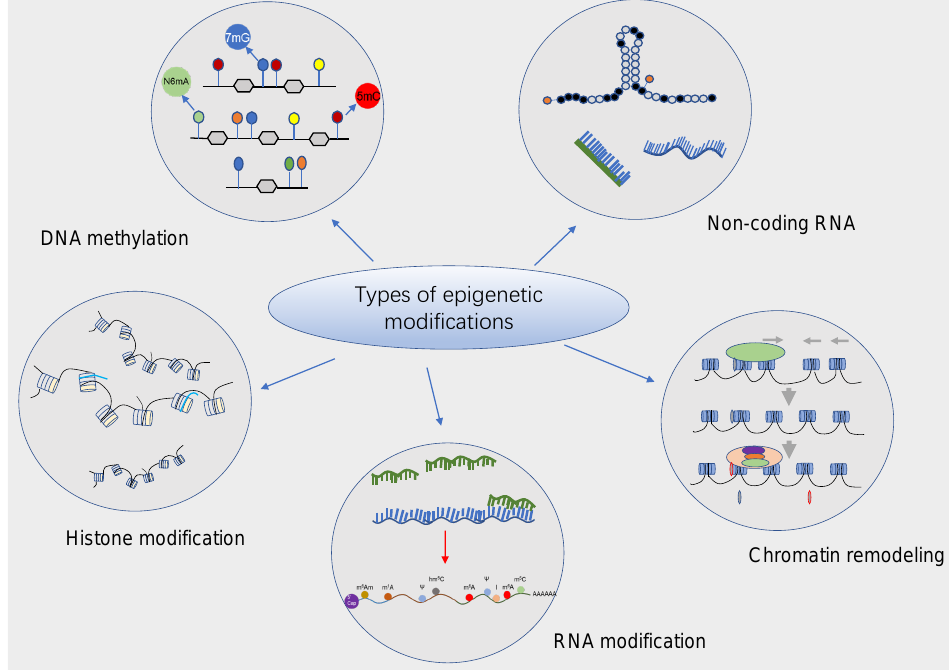
Figure 1. Potential epigenetic regulatory mechanisms in hematologic malignancies. Epigenetic modifications are heritable alterations that can generate changes in gene activity independent of changes in gene nucleotide sequences, including DNA methylation, histone modifications, chromatin remodeling, non-coding RNA, and RNA and RNA modifications, etc., which primarily mediate changes in gene transcription as well as translation activity. Numerous studies have confirmed that epigenetic modifications (e.g., DNA methylation and histone modifications) play an essential role in the development and progression of hematologic malignancies and are considered to be a vital target for the treatment of different types of leukemias and other hematologic